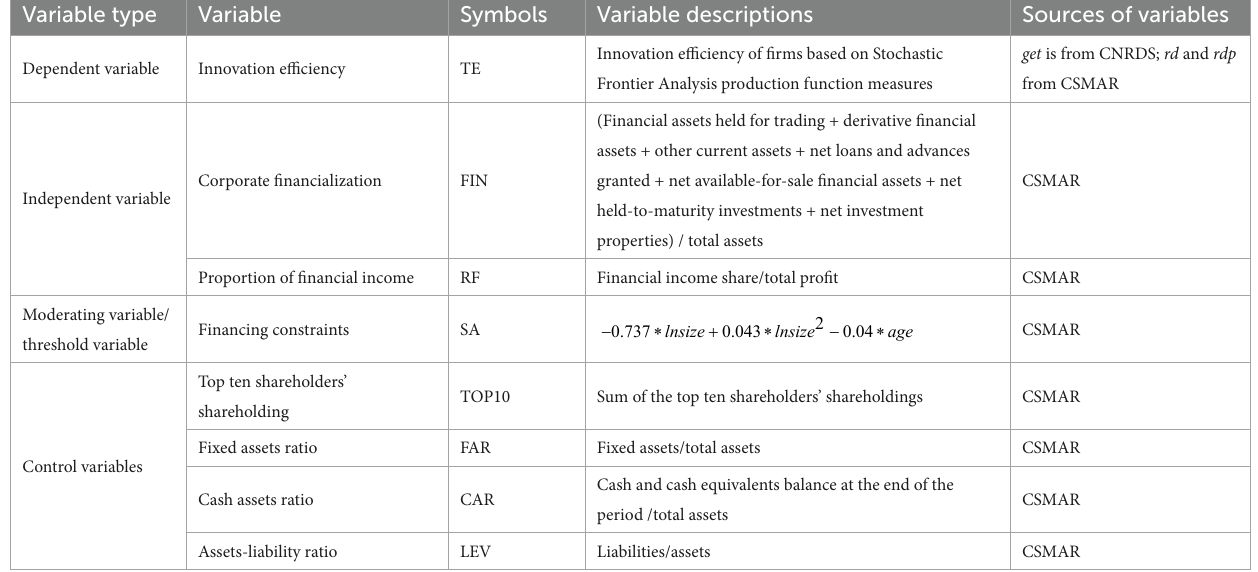
TABLE 1 Variable selection and